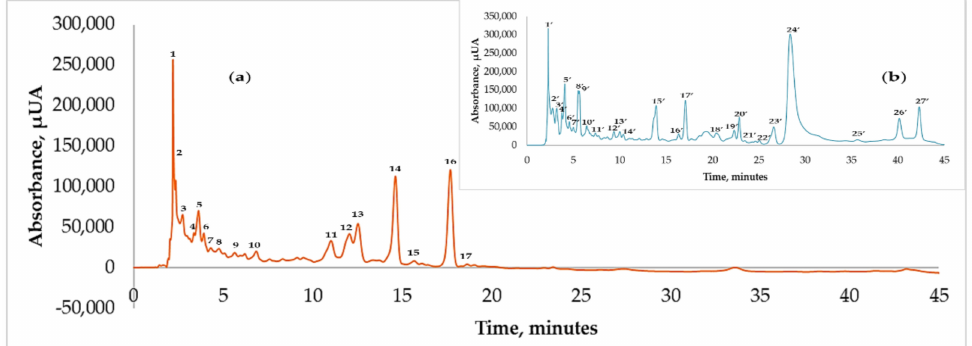
Figure 6. RP-HPLC-DAD ( λ = 280 nm) chromatograms for the flavonoids and polyphenols in the optimized sourdough ( a ), and the unfermented optimized dough ( b ), according to the elution pattern and the chromatographic conditions described in Section 2.4. The injection volume (IV) was 10 µ L and the concentration of the sample was 400 mg/mL. Peak’s identification: 9—caffeic acid; 10—vanillic acid; 12—ferulic acid; 8 (cid:48) —chlorogenic acid; 9 (cid:48) —caffeic acid; 10 (cid:48) —vanillic acid; 23 (cid:48) —quercetin; 24 (cid:48) —gallic acid; 26 (cid:48)